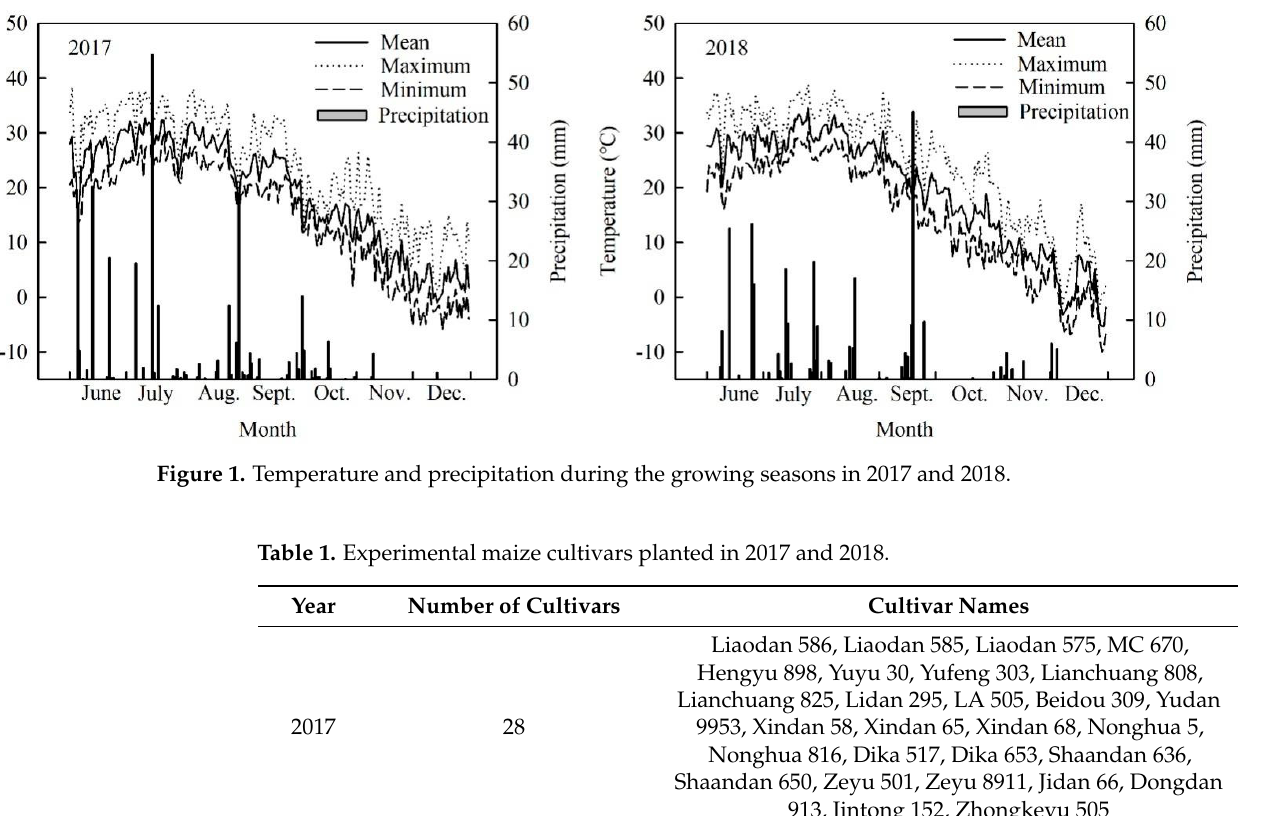
Table 1. Experimental maize cultivars planted in 2017 and 2018.